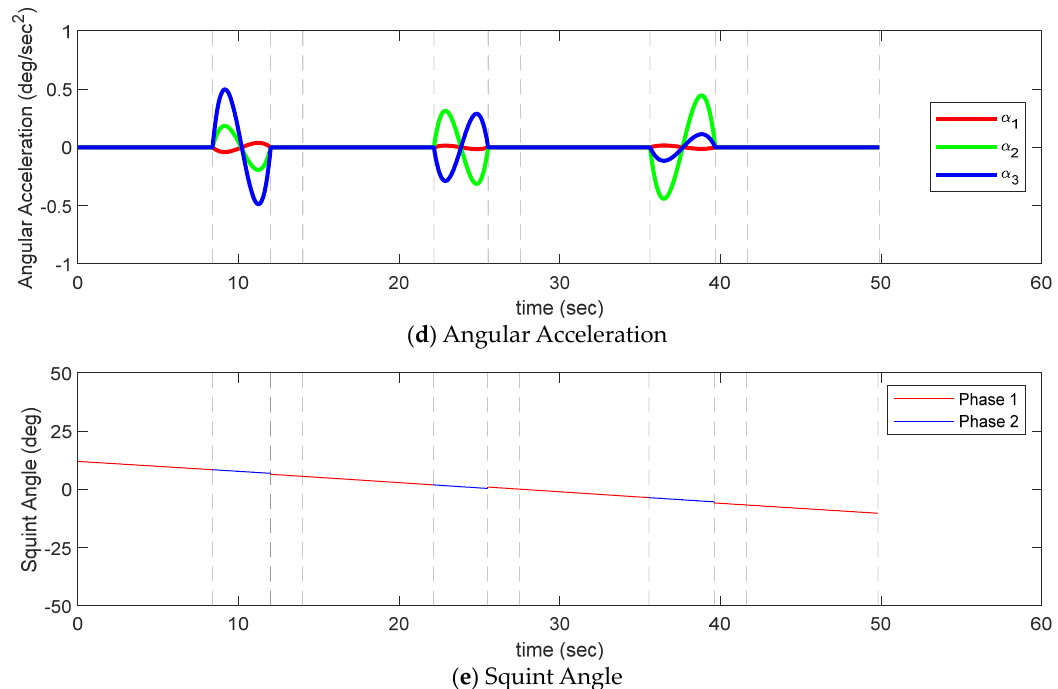
Figure 22. Timeline/quaternion/angular velocity/angular acceleration/squint angle for Scenario 2.